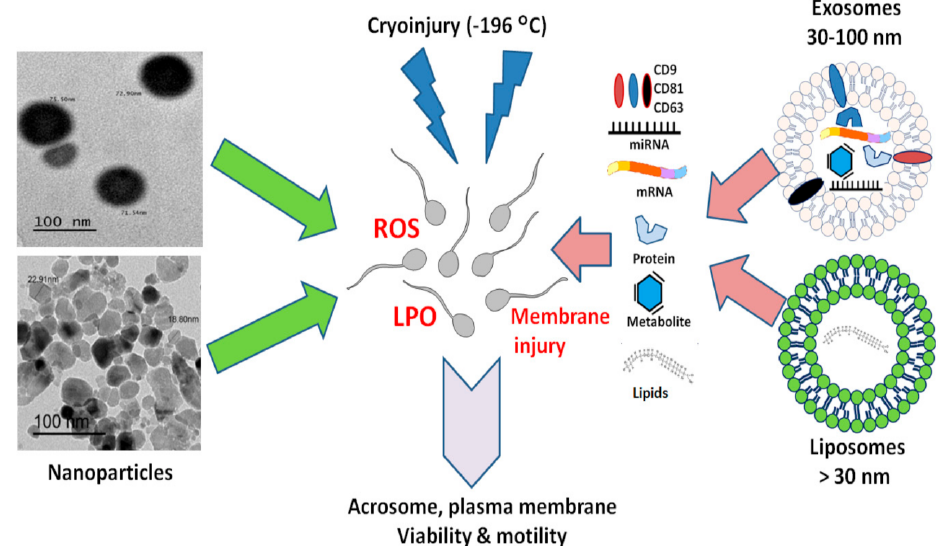
Figure 2. The overall e ff ects of nanoparticles, exosomes, and liposomes in improving semen cryopreservation and reducing cryoinjury. Nanoparticles either from metals or from natural herbs act mainly as antioxidants, while exosomes can deliver bioactive components such as antioxidant enzymes, proteins, lipids, mRNA, and miRNA to protect sperm against cryoinjury such as that caused by reactive oxygen species (ROS) and lipid peroxidation (LPO). Liposomes can fuse with the sperm plasma membrane and replenish the damaged phospholipids caused by freezing /